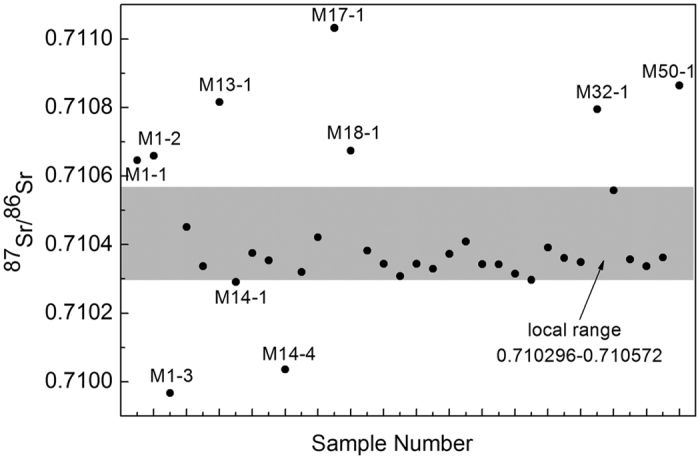
Scatter chart of 87Sr/86Sr ratios for human enamel with local range in gray.